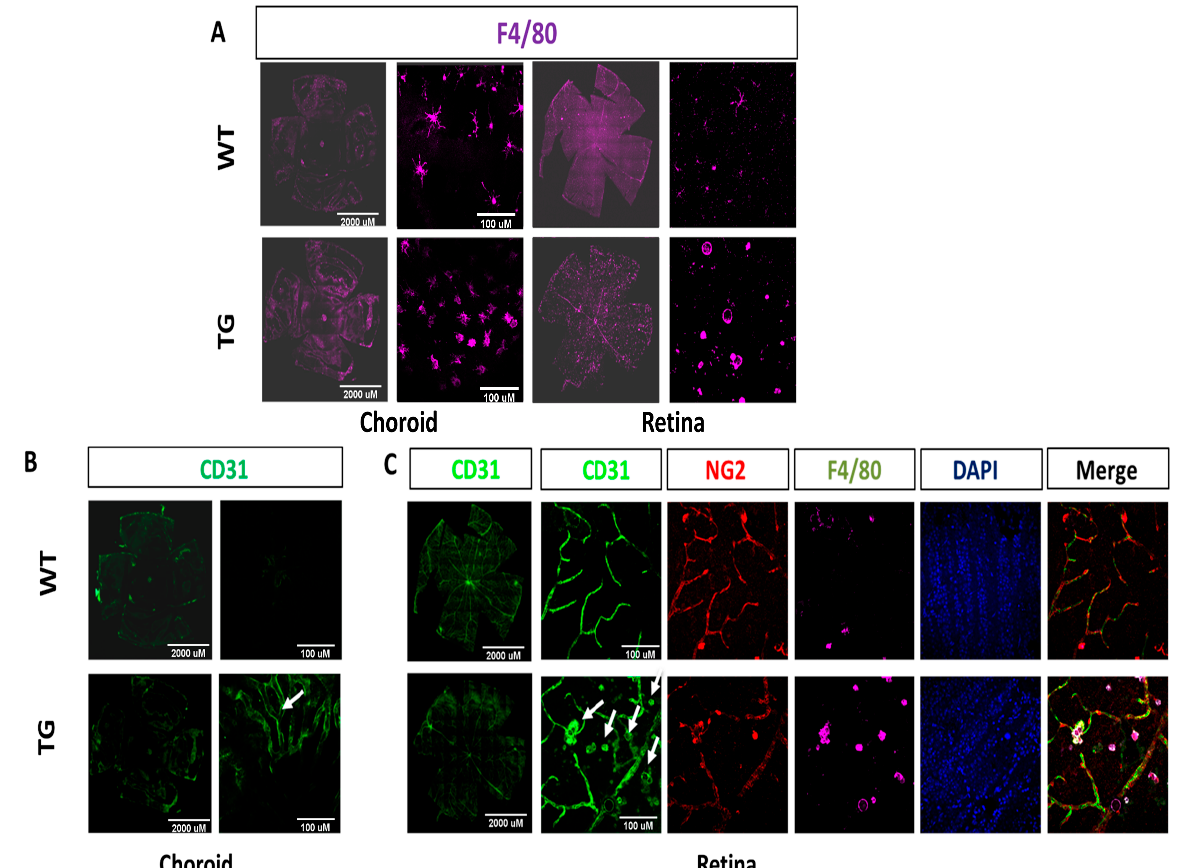
Figure 6. Macrophage infiltration and activation in subretina and retina of CAG-HtrA1 Tg mice compared to wild-type control. Representative images of flat mount of retina and choroid separated from CAG-HtrA1 Tg mice (27 months) and wild-type control (29 months). ( A ) F4/80 (macrophage infiltration) ( B ) torturous choroidal vessels (white arrows) were observed in HtrA1 Tg mice. ( C )